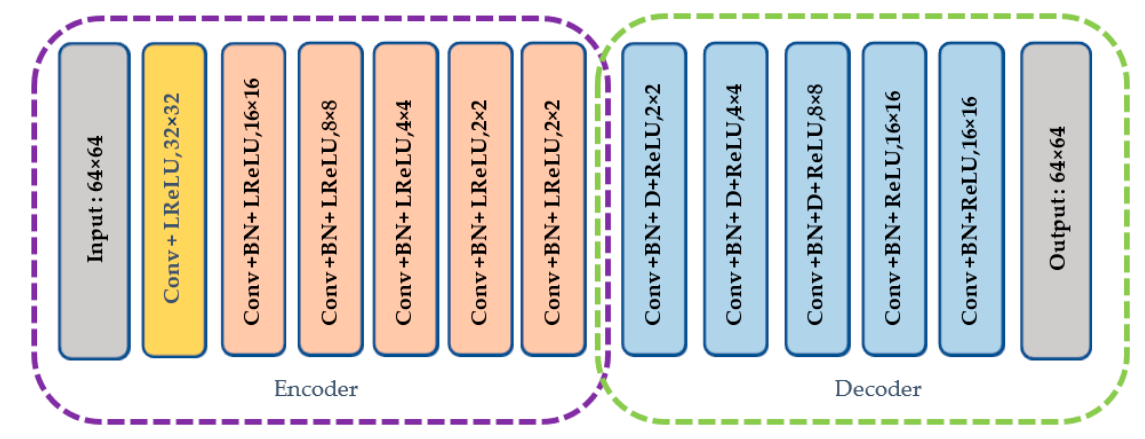
Figure 2. Architecture of generator.